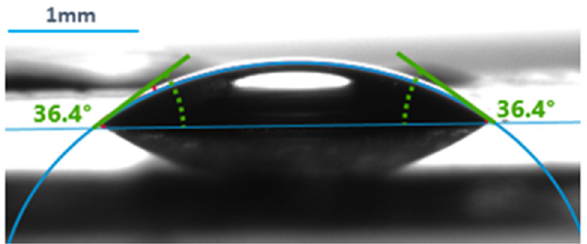
Figure 2. An example of contact angle measurement using the Krüss Advance Drop Shape